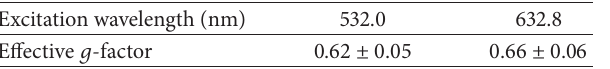
Figure 9: Calculated effective anisotropy factor substituted in (1) and experimental most probable photon path for (a) 532 nm excitation and (b) 632.8 nm excitation. Distance between fibres is 2.2 mm. Table 3: Effective fluorescent 𝑔 -factor for the two-excitation wave-